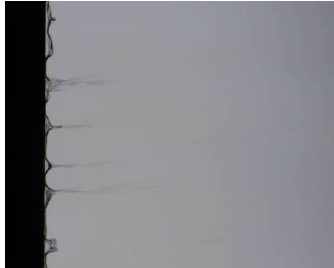
Fig. 6. Saturated solution of the sodium chloride